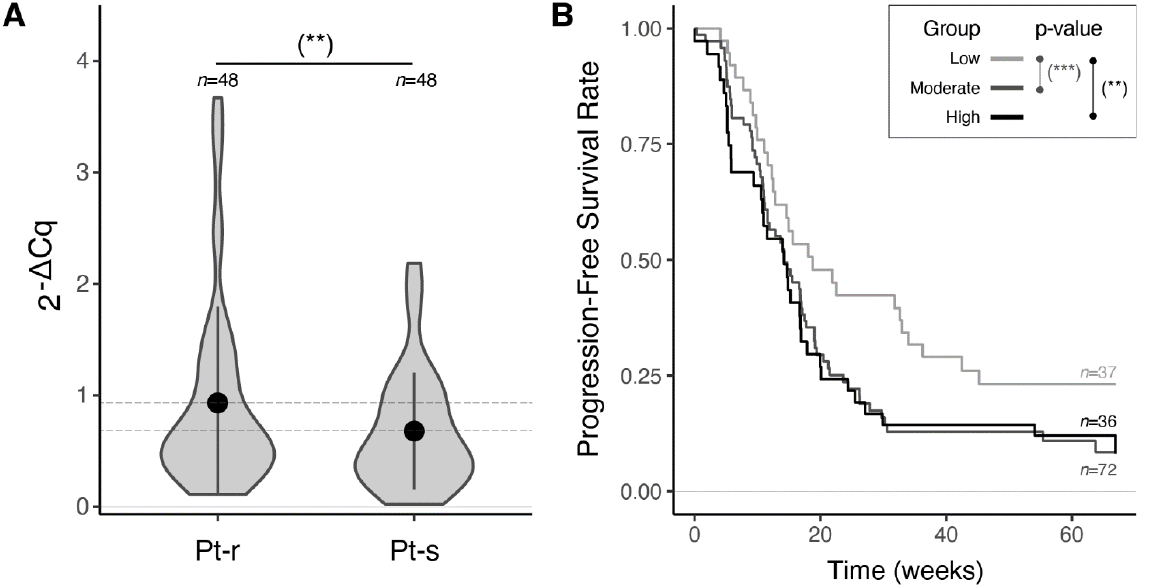
Figure 2. Prognostic performance of miR-23a-3p in the Brescia cohort. ( A ) Violin plots and error bars (mean +/ − standard deviation) showing normalized miR-23a-3p expression levels measured by RT-qPCR in HGSOC samples from platinum-resistant patients (Pt-r) compared to platinum-sensitive patients (Pt-s) ( p -value = 0.03, one-sided t -test). Complete results in Table 4. ( B ) Progression-free survival curves (Coxph model adjusted by residual tumor, age and Bevacizumab), stratified by quartiles of normalized miR-23a-3p expression levels (Q 1 : low; Q 2 – Q 3 : moderate; Q 4 : high). Complete results in Supplementary Results Table S4. (**) p ≤ 0.05, (***) p ≤ 0.01.